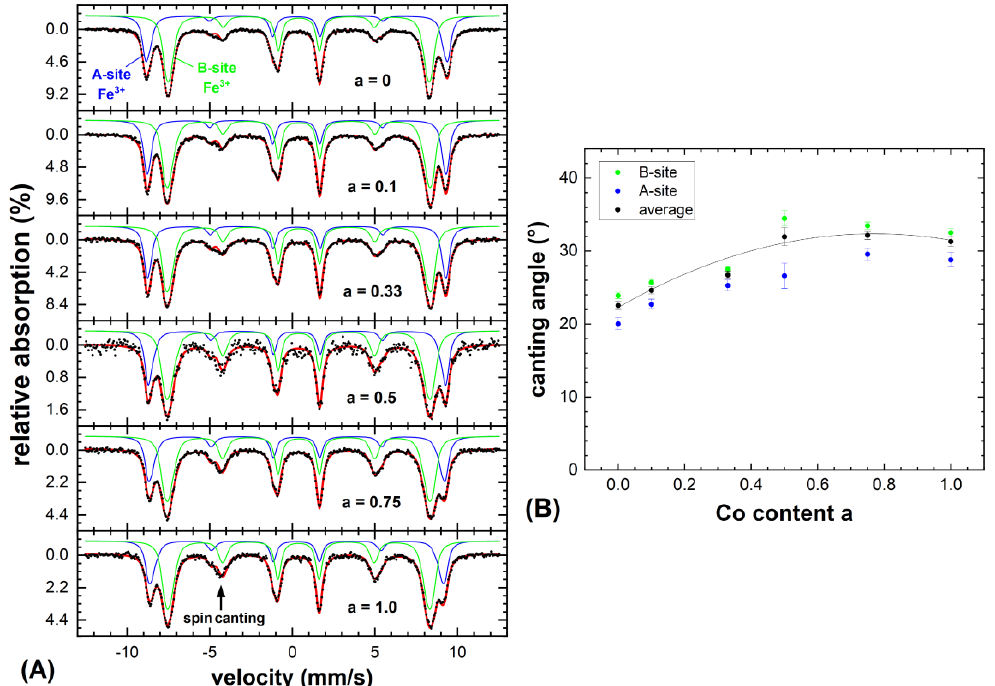
Figure 4. ( A ) Mössbauer spectra of the Co a Fe 3-a O 4 nanoparticles recorded at 4.3 K in a magnetic field of 5 T applied along the γ -ray incidence direction, composed of Fe 3 + ions on the tetrahedral A-(blue) and the octahedral B-sites (green). Narrow hyperfine field distributions were used to reproduce the individual subspectra. ( B ) Spin canting angles extracted for the A- and B-site iron and averaged canting angles; the line serves as a guide to the eye only.